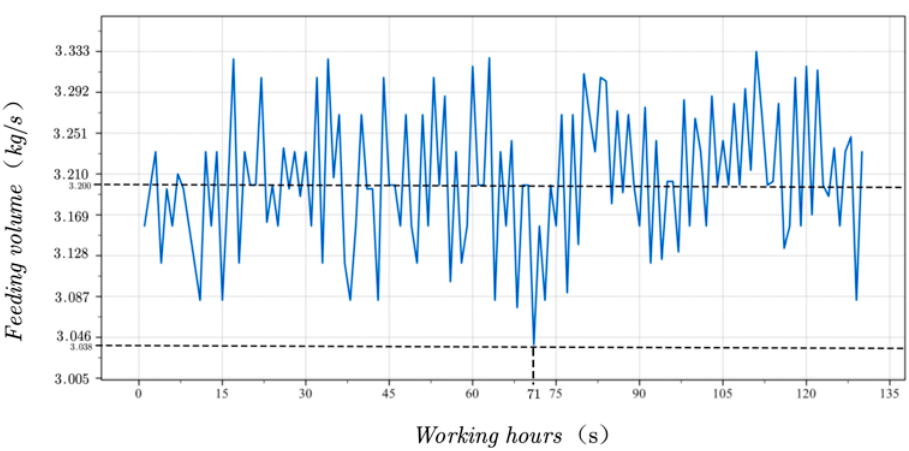
Figure 18. Time domain diagram of feeding volume.